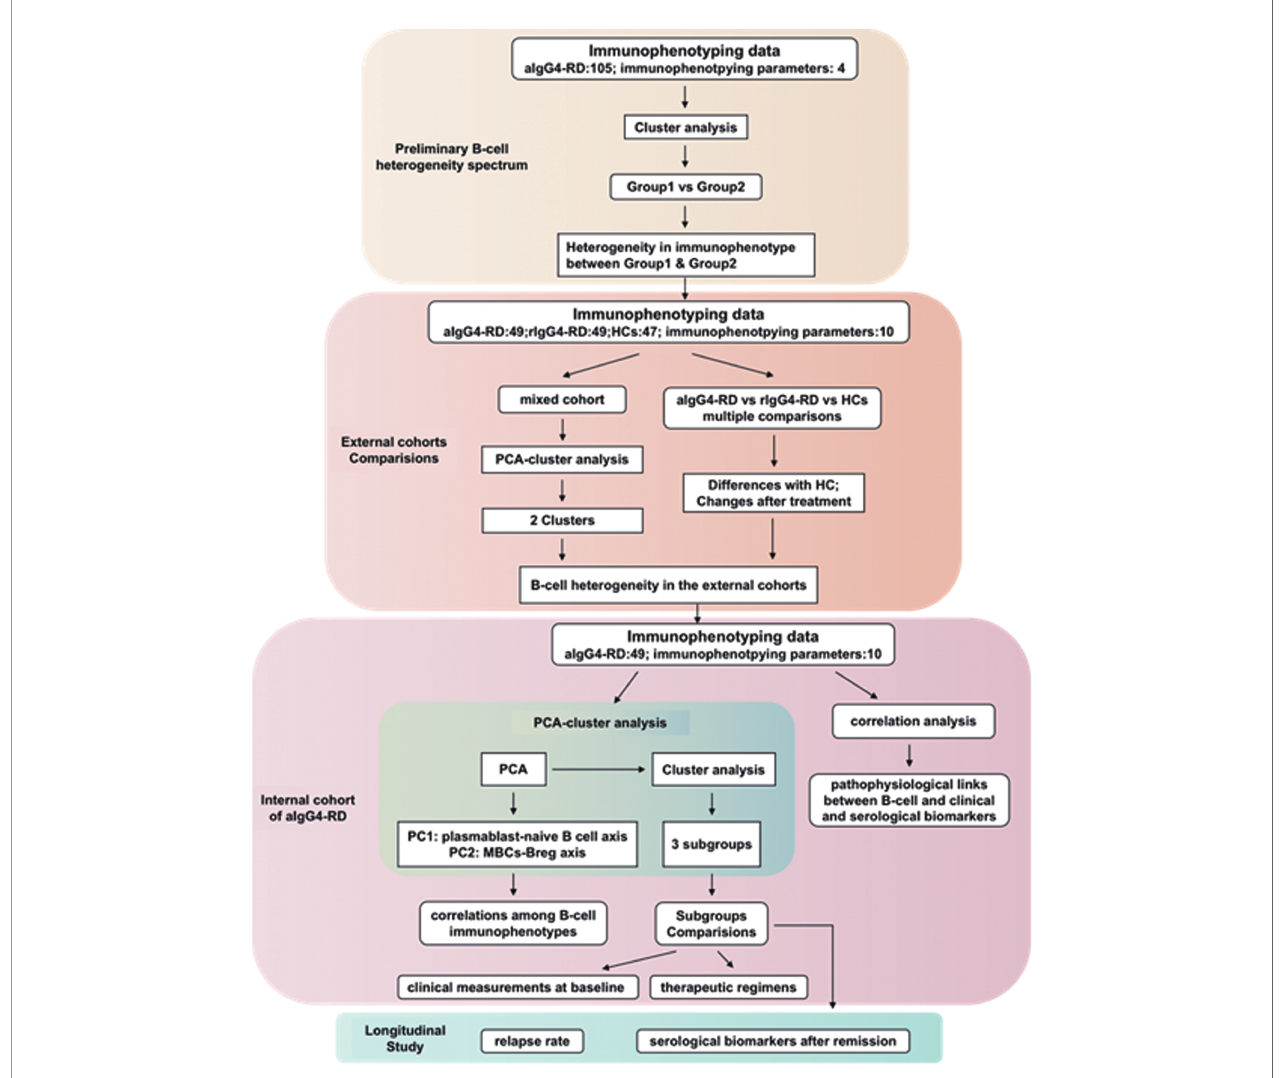
FIGURE 1 | The fl ow scheme of study design. HCs, (healthy controls); aIgG4-RD, (active IgG4-RD); rIgG4-RD, (remissive IgG4-RD); PCA, (principal components